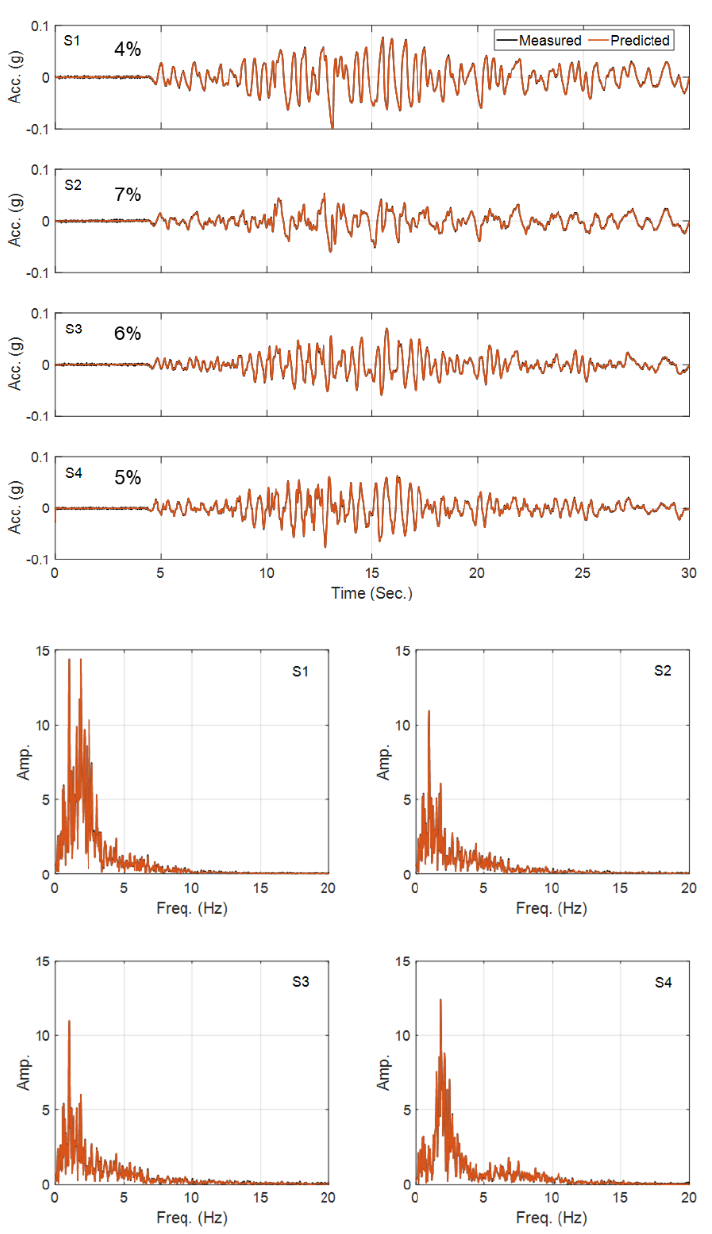
Figure 7. Comparison between the measured and predicted acceleration responses in Case Study 1 (top—time domain; bottom—frequency domain). Table 1. The initial and final error of estimation parameters for Case Study 1.